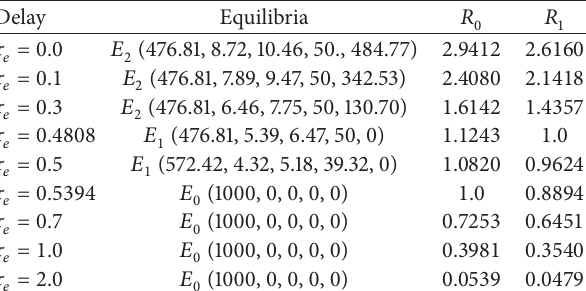
Figure 10: The concentration of B cells for model (104). Table 3: The values of equilibria, 𝑅 0 , and 𝑅 1 for model (104) with different values of 𝜏 𝑒 .